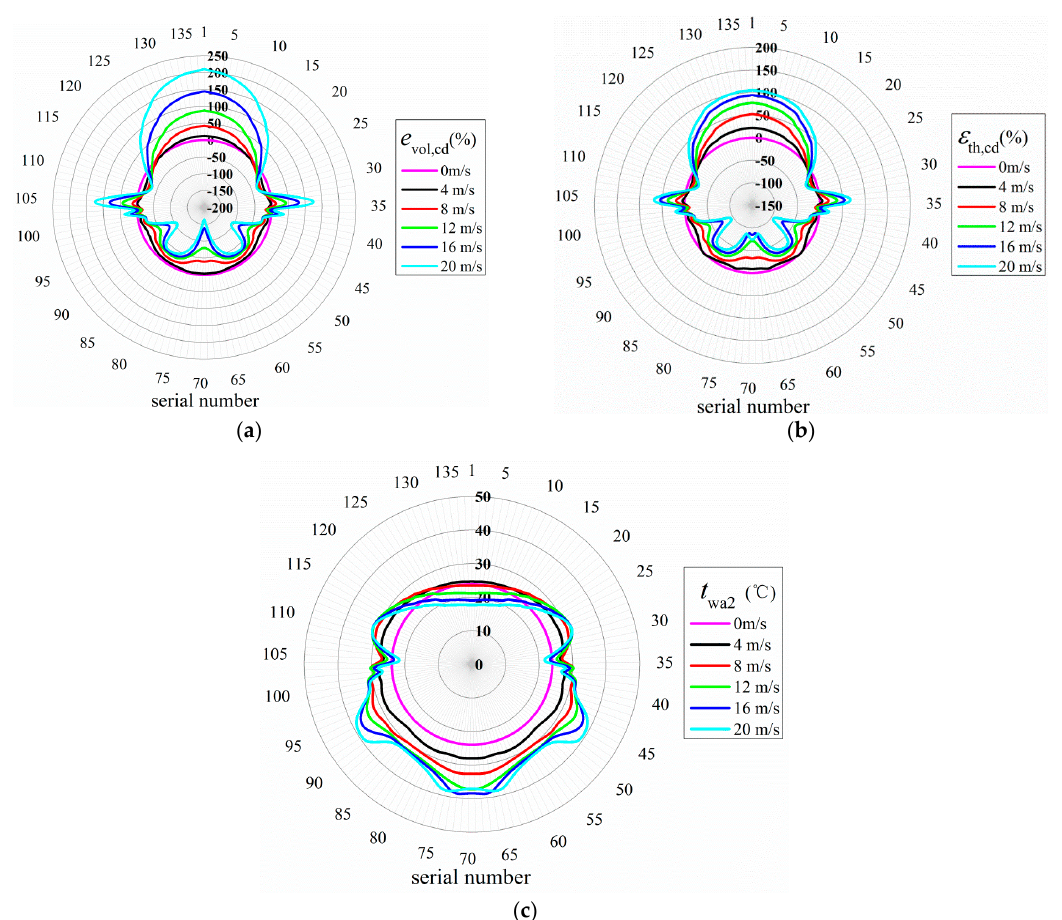
Figure 14. Performance distributions for case C. ( a ) Volume effectiveness; ( b ) Thermal efficiency; ( c ) Outlet water temperature.